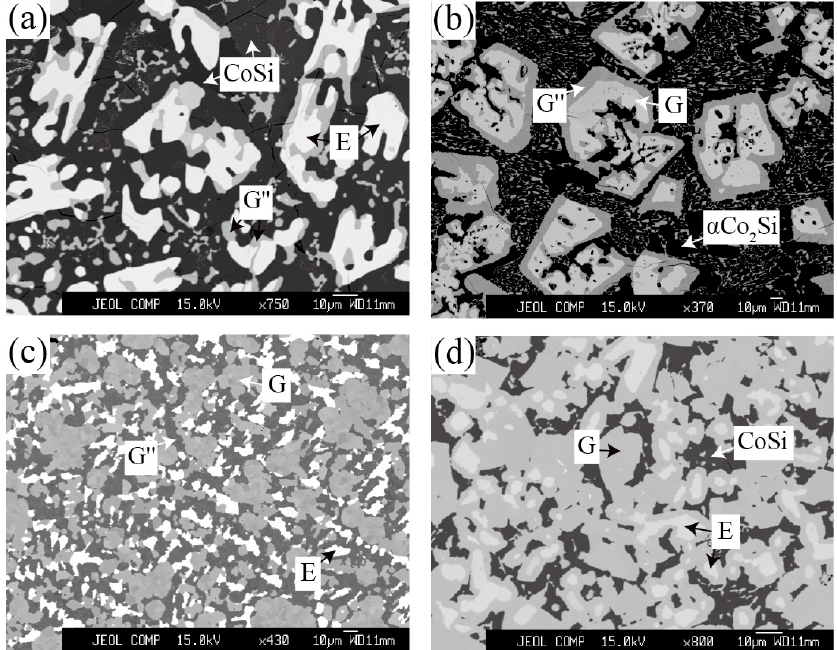
Figure 6. Typical ternary micrograph images obtained of ( a ) Co 46 Ta 13 Si 41 alloy annealed at 1100 °C for 60 days; ( b ) Co 58 Ta 10 Si 32 alloy annealed at 1100 °C for 60 days; ( c ) Co 48 Ta 22 Si 30 alloy annealed at 1100 °C for 60 days and ( d ) Co 48 Ta 22 Si 30 alloy annealed at 900 °C for 90 days.